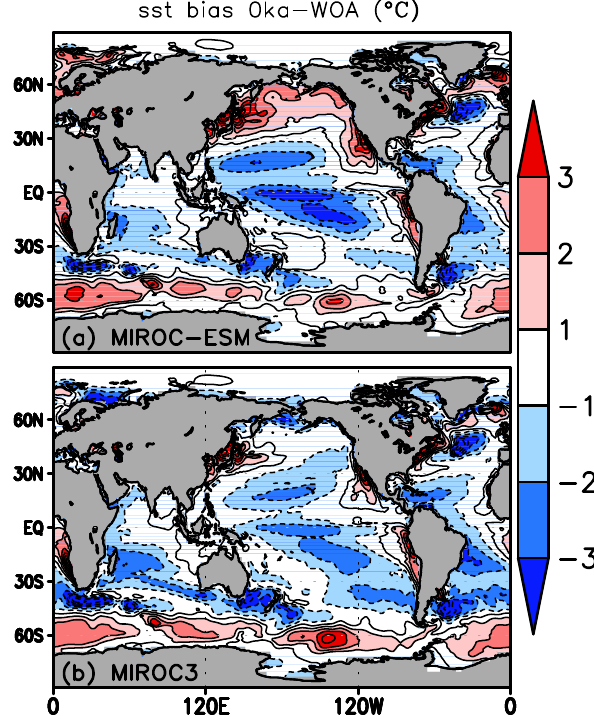
Fig. 2. 0ka annual SST biases in (a) MIROC-ESM and (b) MIROC3 compared with the World Ocean Atlas